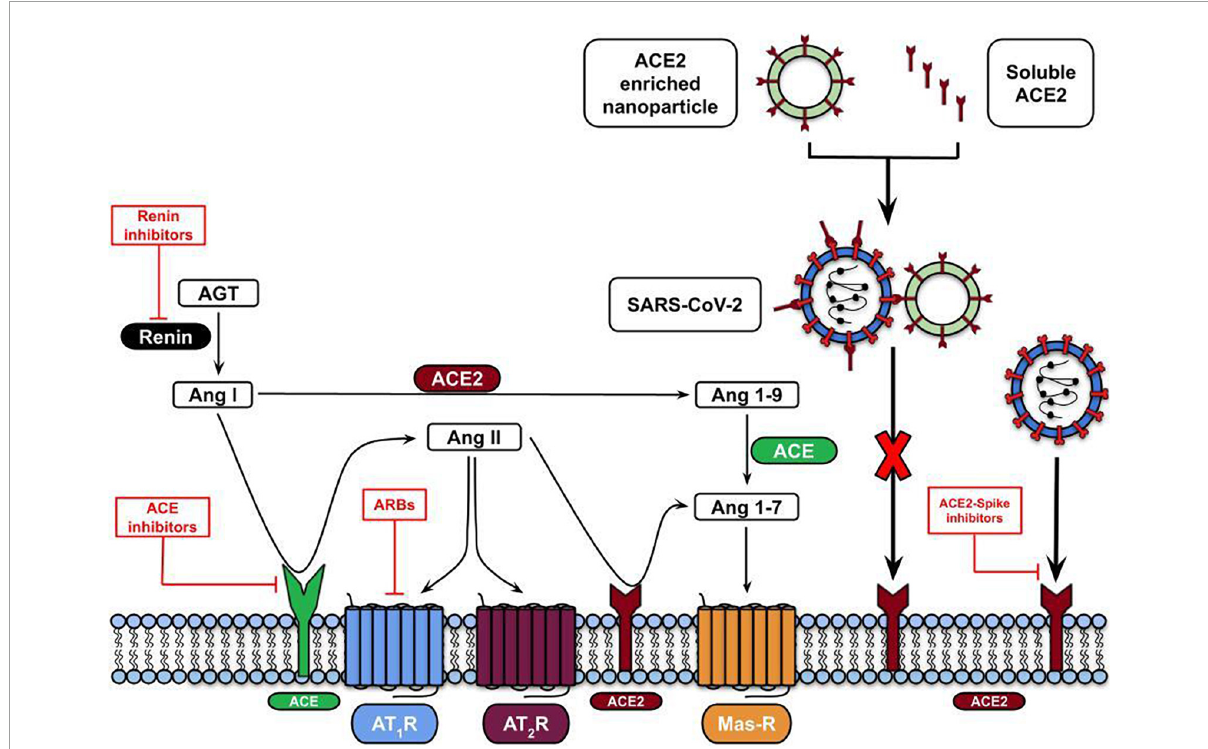
FIGURE3 RAS-mediated therapeutic approaches against SARS-CoV-2 infection. The therapeutic approaches involve using ARBs (Angiotensin II receptor blockers) to inhibit the binding of Ang II to AT1R (red lines) or virus entry blocking by using the ACE2 soluble form or embedded in